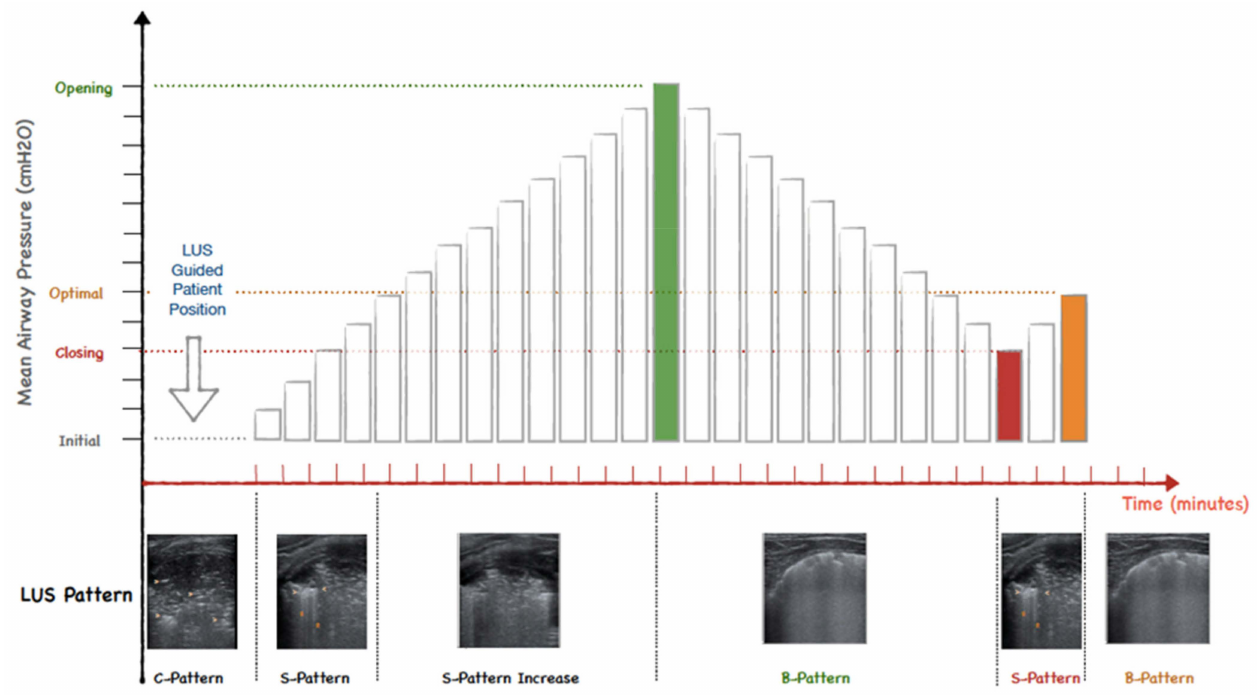
Figure 1. Lung UltraSound Targeted Recruited (LUSTR)